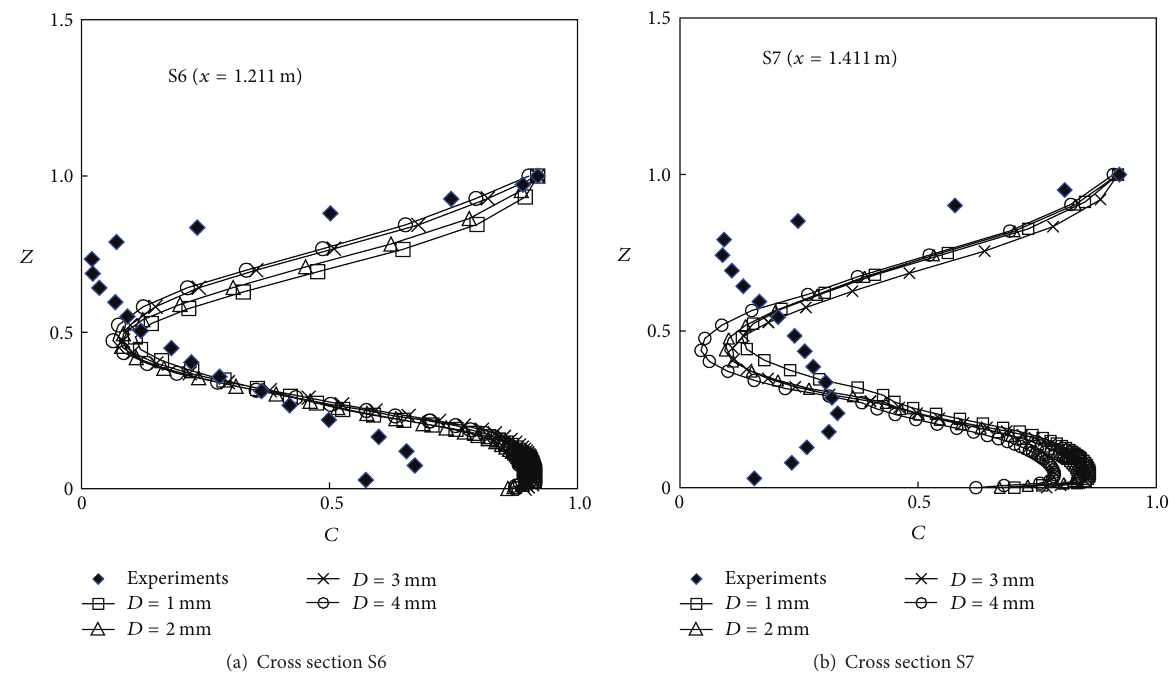
Figure 11: 𝐶 distribution at S6 and